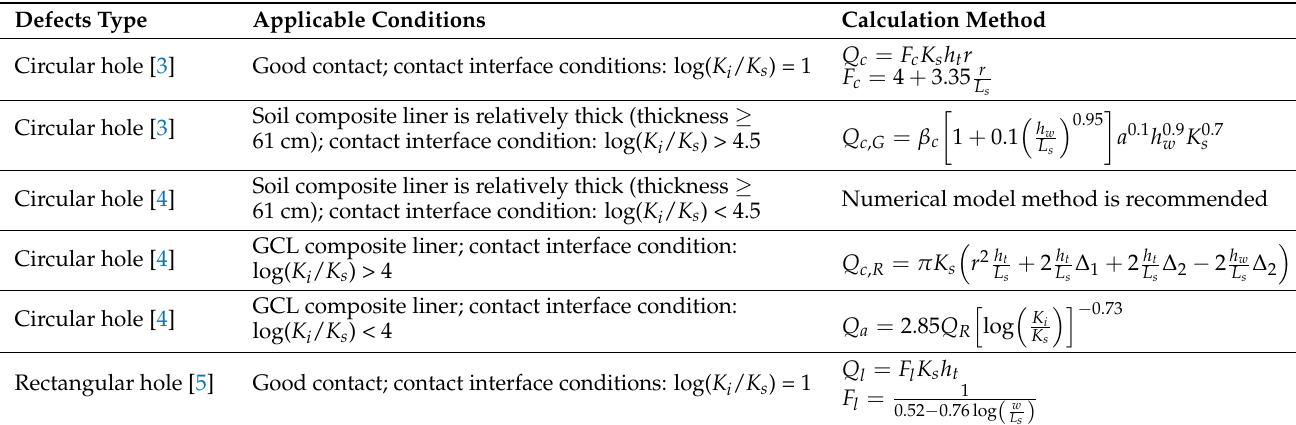
Table 2. Calculation method of leakage rate of different